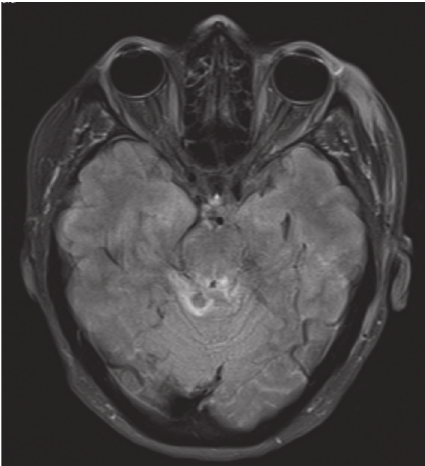
Figure 1: Axial FLAIR MRI showing Grade III DAI with hy- perintense lesions at the level of the tectum of the midbrain, in the superior cerebellar parenchyma and the superior cerebellar